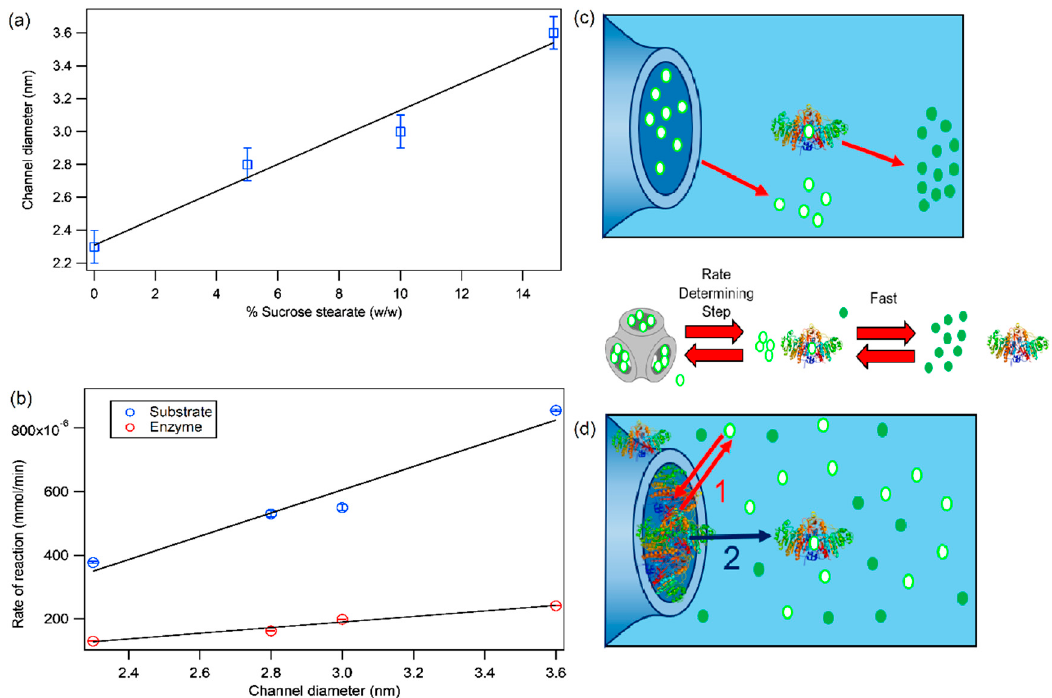
Figure 5. Summary: effect of substrate and enzyme confinement on AP-catalysed reaction rate and mechanism. ( a ) Channel sizes of Phyt cubic mesophases as a function of the sucrose stearate content (%) (blue markers); linear fit of the experimental data (black continuous line); ( b ) Experimental rates of the enzymatic reaction, vs. channels size (nm), for the case of confined substrate (blue markers) and confined enzyme (red markers); linear fit of the experimental data (black continuous lines); ( c–d ) scheme sketching the hypothesized reaction mechanisms in the case of the confined substrate ( c ) and confined enzyme ( d ), according to the experimental data: in the case of the confined substrate the hypothesized mechanism is the diffusion of the substrate from the aqueous channels to the surrounding solution as the limiting reaction step, followed by the fast conversion into the product by the enzyme (see scheme d); in the case of the confined enzyme, two possible mechanisms could be considered, or a combination of both, i.e., the escape of the enzyme in the surrounding solution where the substrate is dispersed ready to be converted (mechanism 2, black arrow), or else the substrate diffuses in the aqueous channels, where the enzyme is confined, and it is converted into the product, which then diffuses back in the surrounding solution (mechanism 1, red arrows).